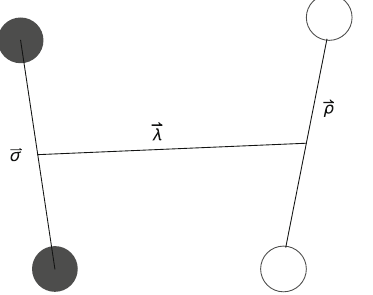
Fig. 1 TetraquarkJacobicoordinatesofEq.(4).Filledandopencircles represent quarks and antiquarks,